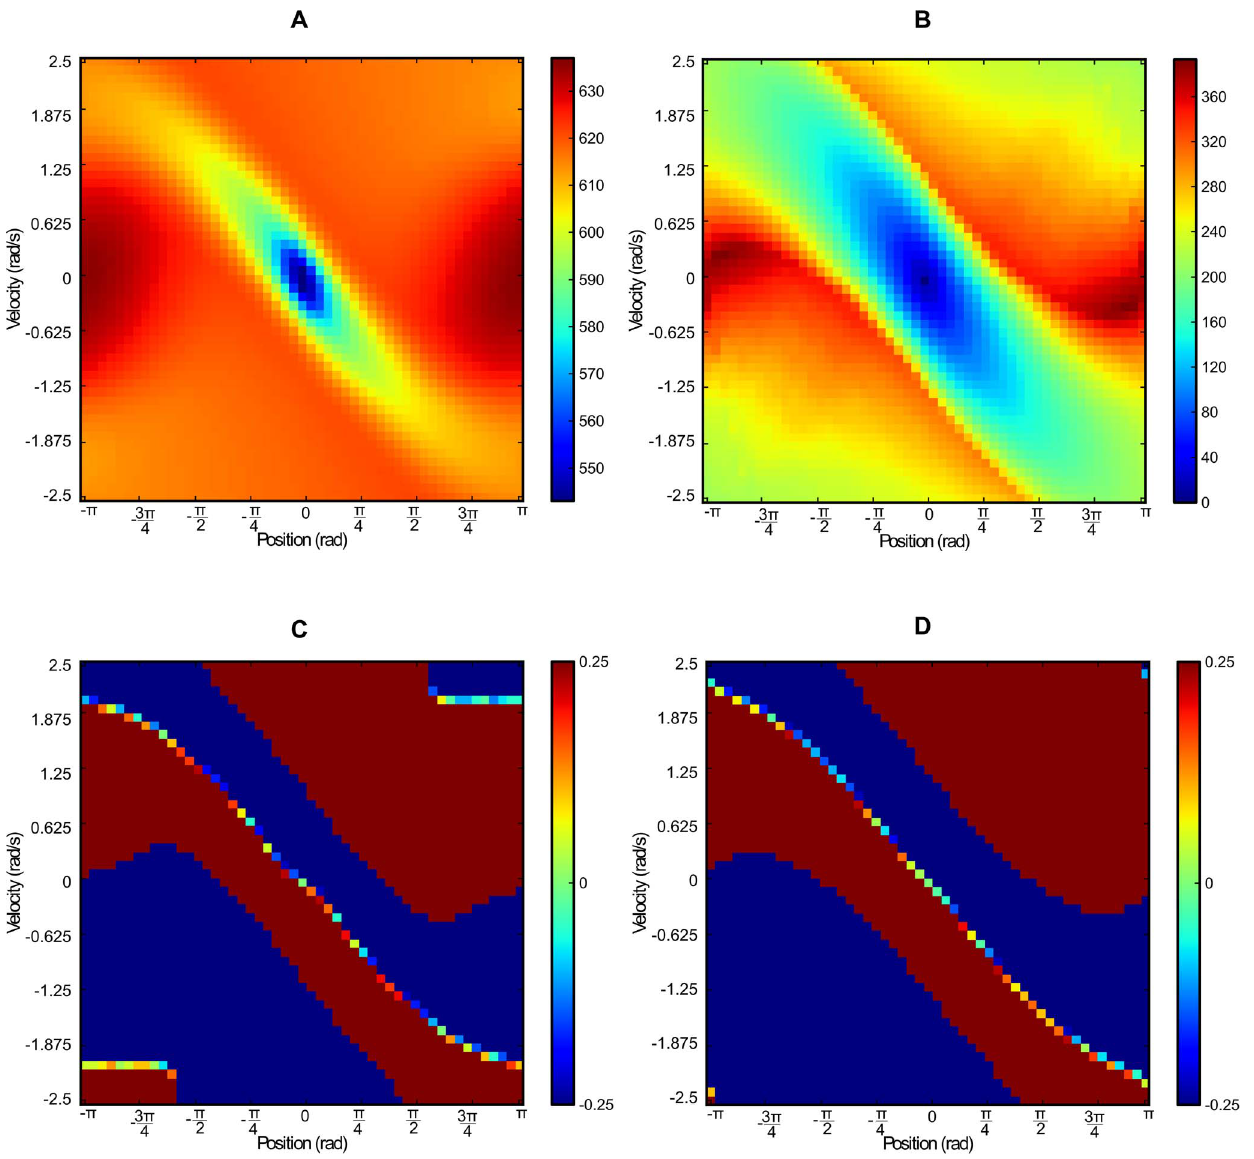
Figure 3. Comparison of obtained value function, quasi-distance and policies for the inverted pendulum system. (A) Value function obtained with undiscounted value iteration. (B) quasi-distance. (C) Policy obtained with undiscounted value iteration. (D) Policy obtained with the quasi-distance (most probable policy).